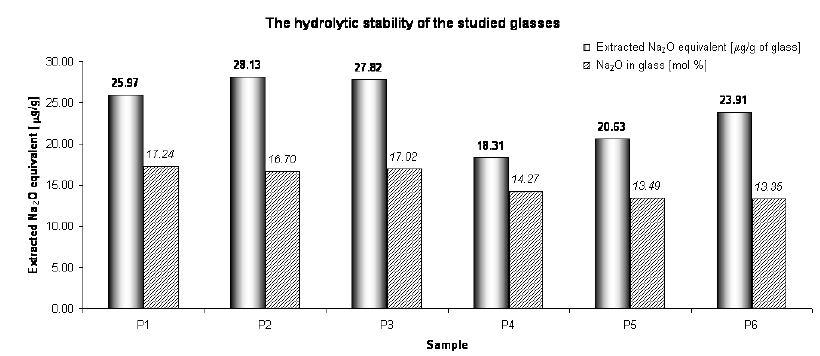
Figure 1. Product Na O content and hydrolytic 2 Table 4. Product glass composition (mol %).